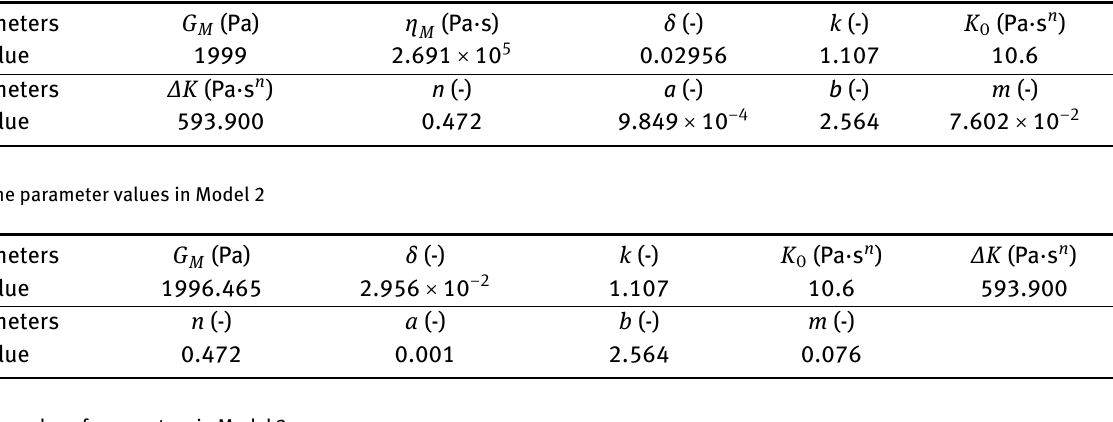
Table 2: The parameter values in Model 1